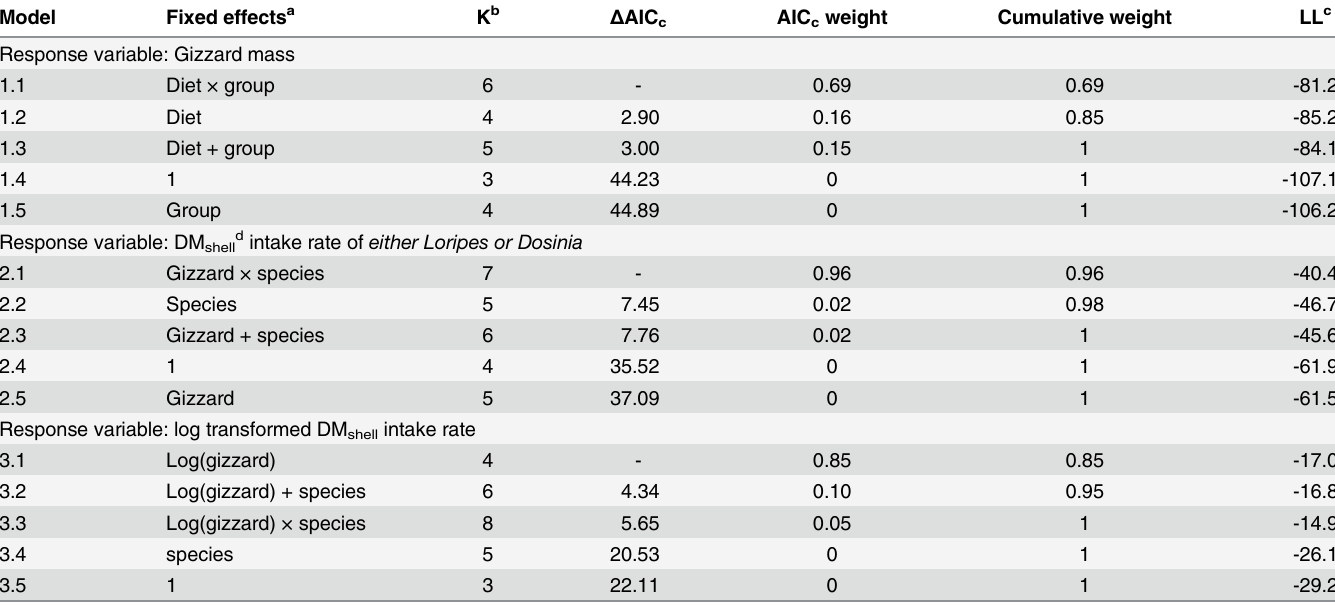
Table 2. Second-order Akaike ’ s information criterion (AIC c ) comparison of statistical models.